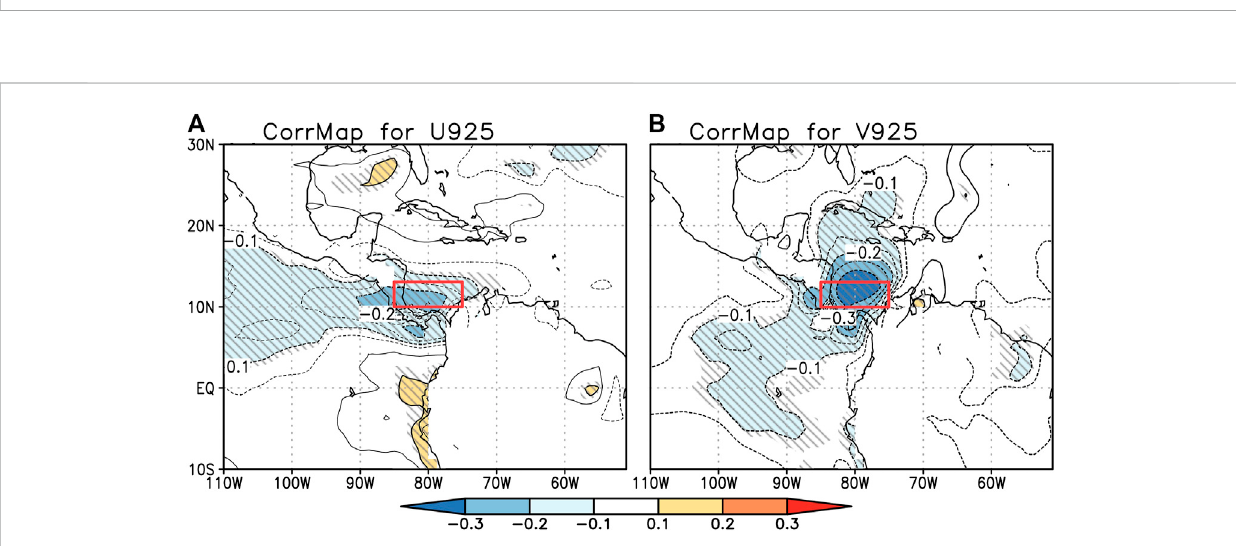
FIGURE 7 Correlation map for easterly (A) and northerly (B) wind speeds at 925 hPa with the amount of morning rain in domain A of Figure 4. Shaded lines indicate ranges that meet the 95% signi fi cance level. The red rectangle indicates the area 75 – 85 ° W, 10 – 12.5 ° N in which the large-scale winds are calculated in Figure